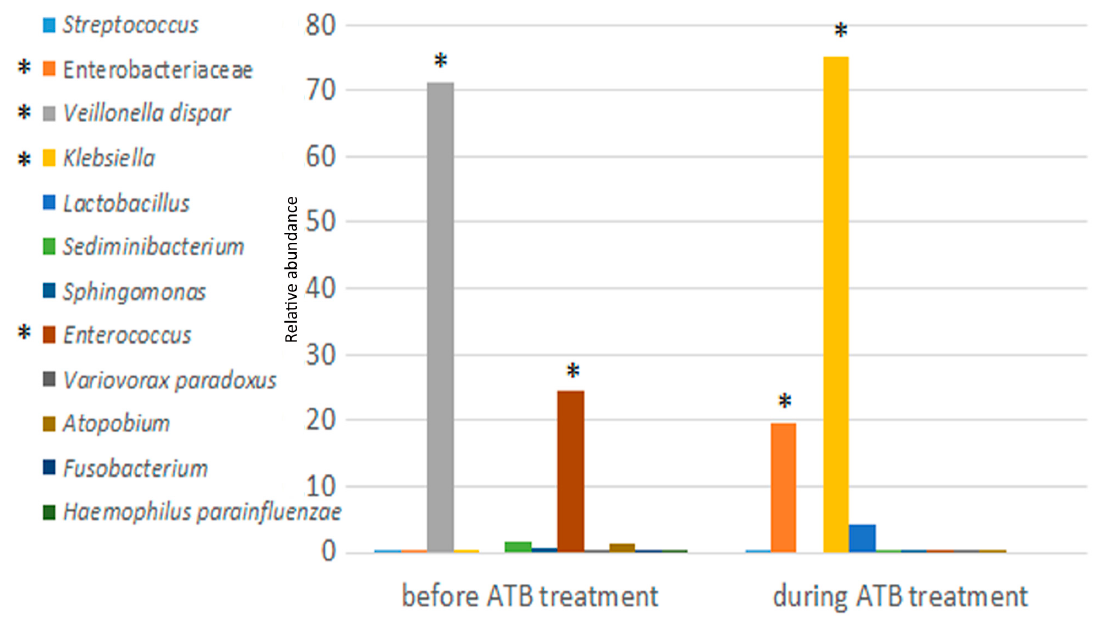
Figure 2. Bar chart comparing operational taxonomic unit (OTU) relative abundances before and during ATB treatment. OTUs at species/family levels were compared using the Mann-Whitney test. Samples were grouped and averaged in “before” and “during ATB treatment” groups of samples. Taxonomic composition is shown at species/family levels. Each column color represents the